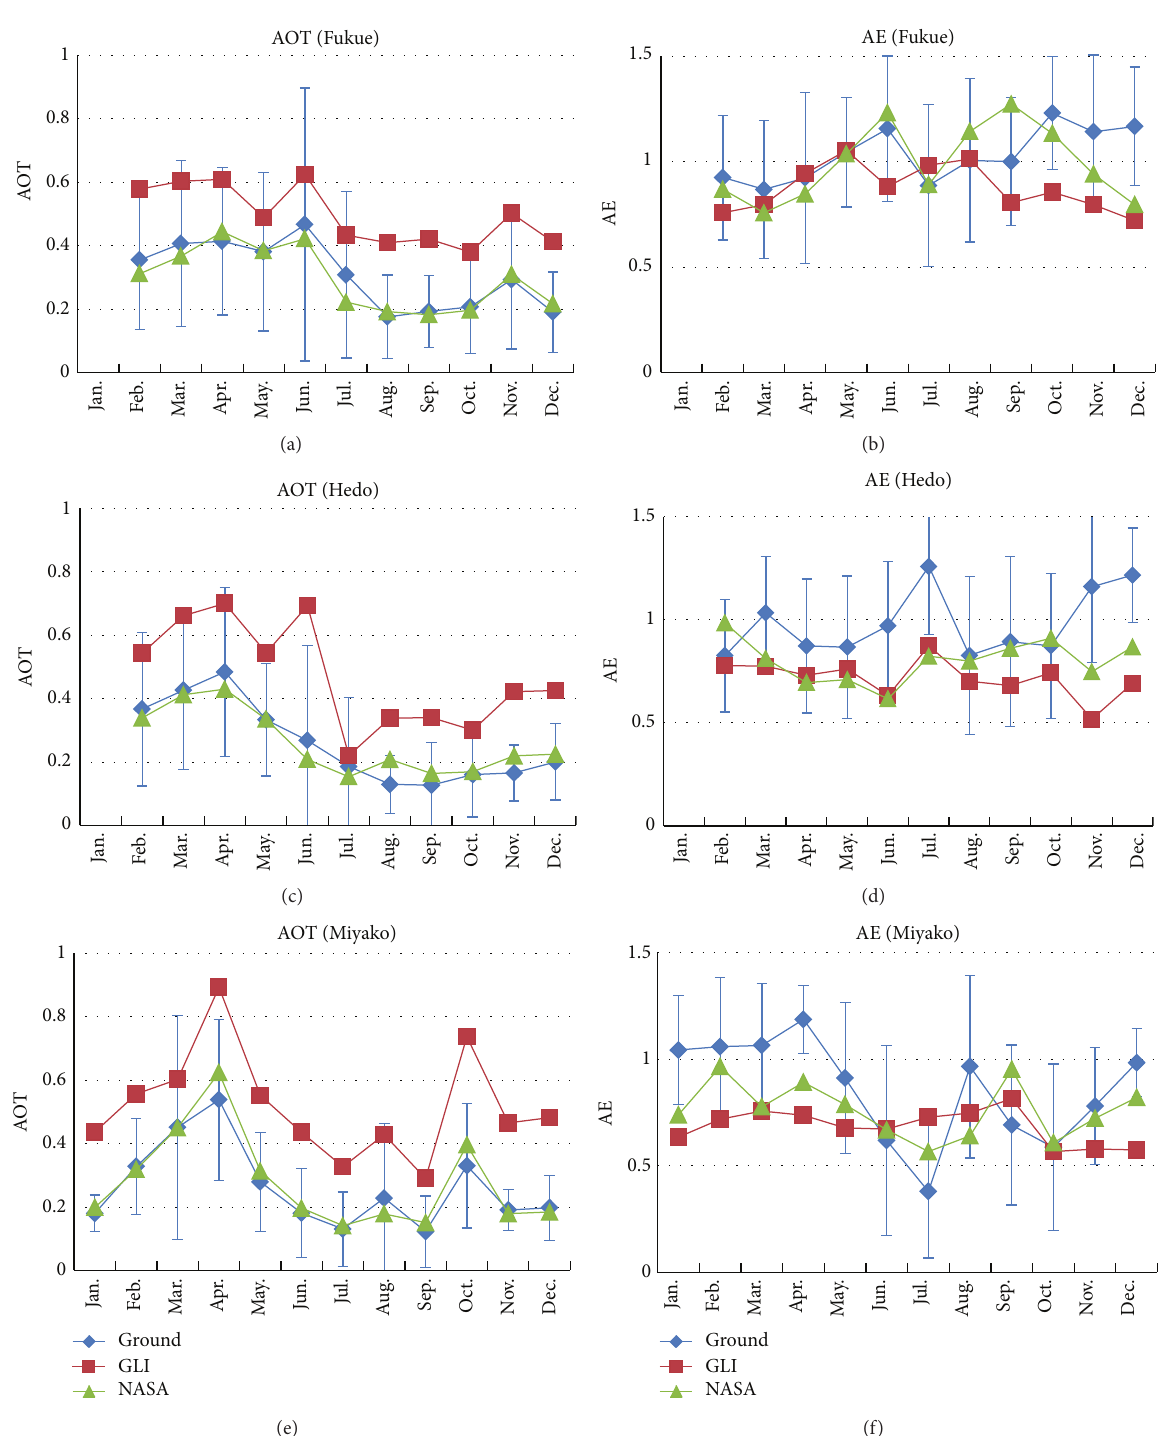
Figure 5: Average monthly variation of the ground (Ground) AOT at the 3 SKYNET sites (Fukue, Hedo, Miyako) and the corresponding satellite retrievals: MODIS-GLI (GLI) and MODIS-NASA (NASA). The errors bars (blue) represent the standard deviation of the monthly ground